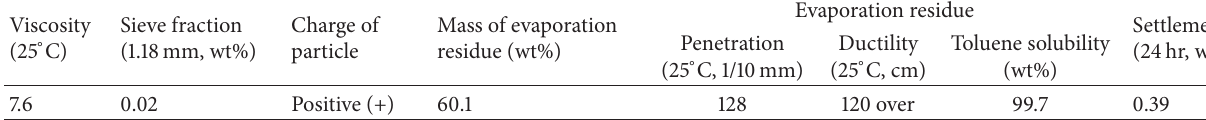
Table 3: Emulsified asphalt MSC-2 properties.